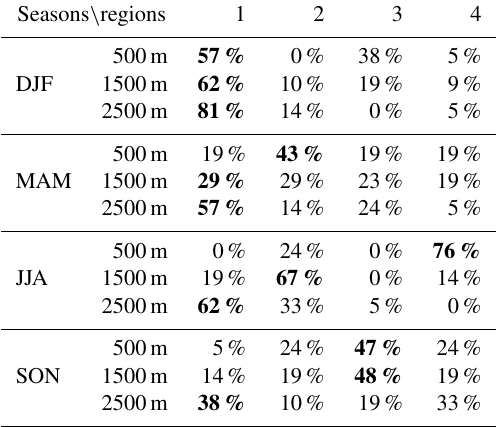
Table 2. Influence of various aerosol sources over the Arabian Sea given as a percentage of trajectories originating from each source respectively. The maximum influence is given in bold. The different source regions are explained in text and in Fig.